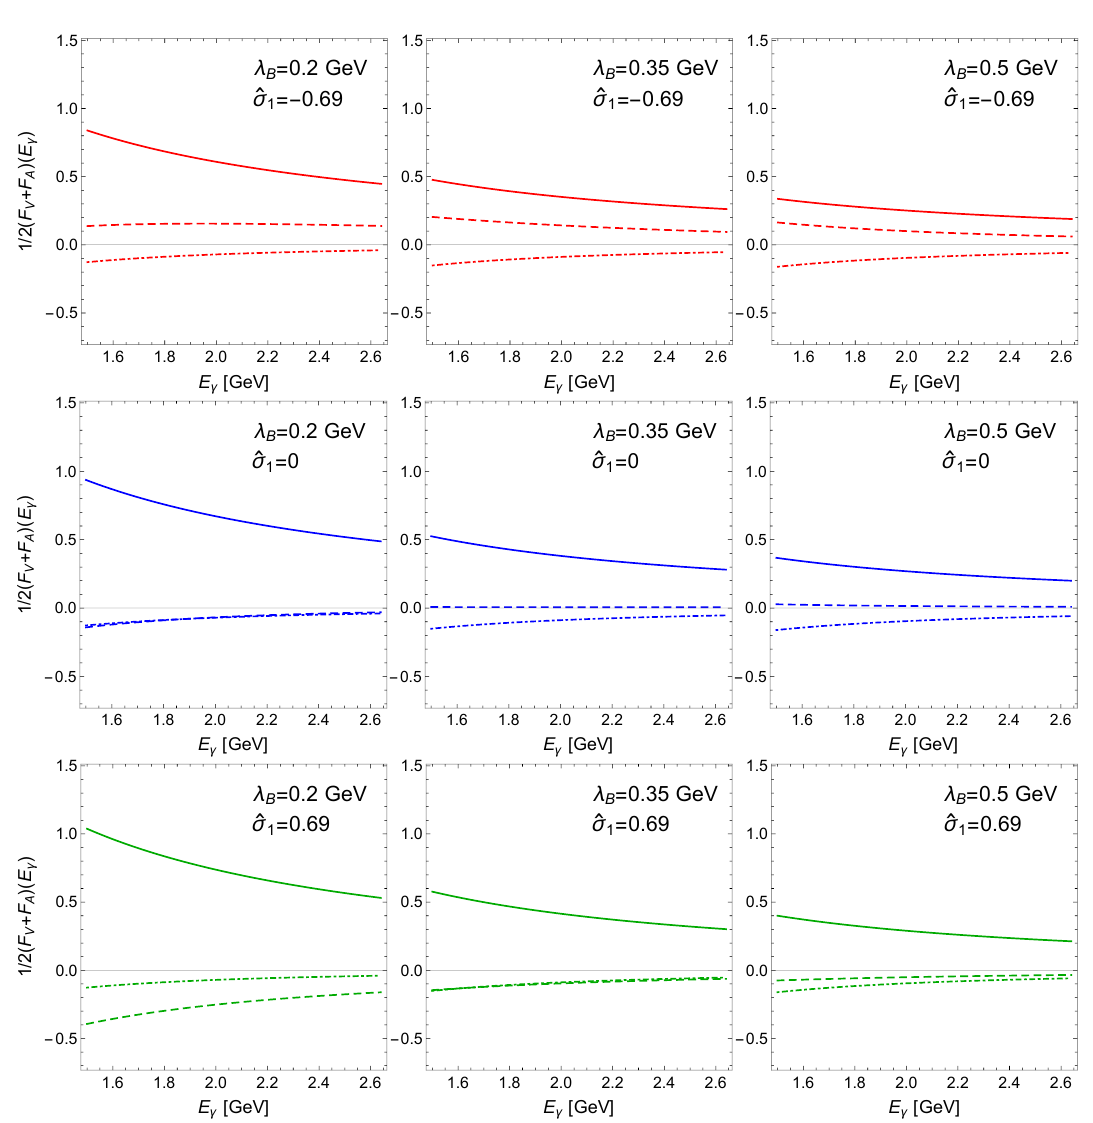
several choices of the parameters (cid:21) result [9] (solid curves), the total soft correction (cid:24) soft = (cid:24) soft the hard-collinear higher-twist correction (cid:24) ht by the solid, dashed and dash-dotted curves, respectively. One sees that the higher-twist correction is negative and relatively small for all cases, whereas the soft correction can be of either sign and for small (cid:21) large. The e(cid:11)ect of the soft correction is always to counteract the change of the perturbative contribution due to the variation of (cid:21) form factor to the model of the LCDA is reduced upon accounting for the soft correction